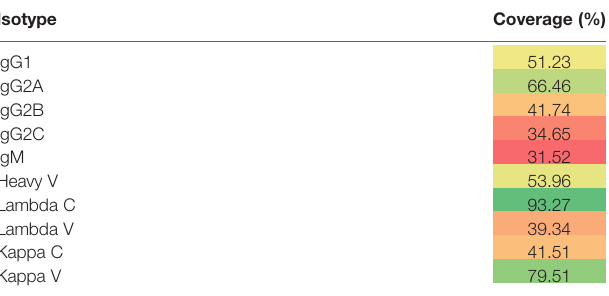
TABLE 2 | Sequence coverage in the SCI data from the different isotypes and regions of immunoglobulins from secretome 1 day after lesion.